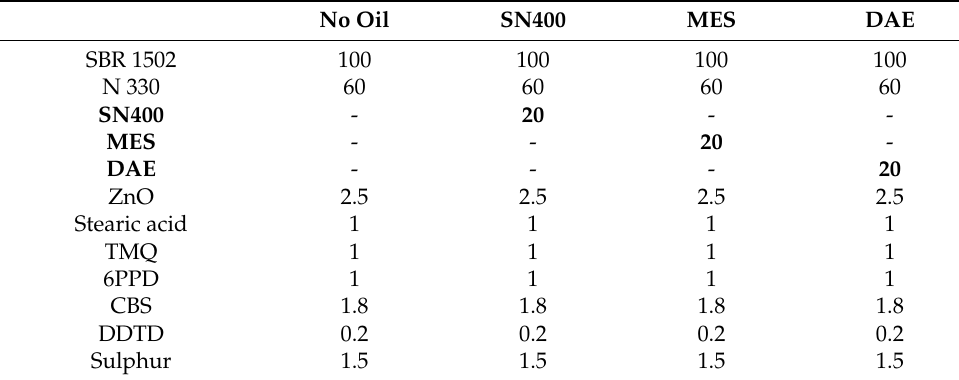
Figure 2. Aniline point and solubility parameter of the plasticizers. The compound formulation is shown in Table 1. Table 1. Compound formulation in phr.